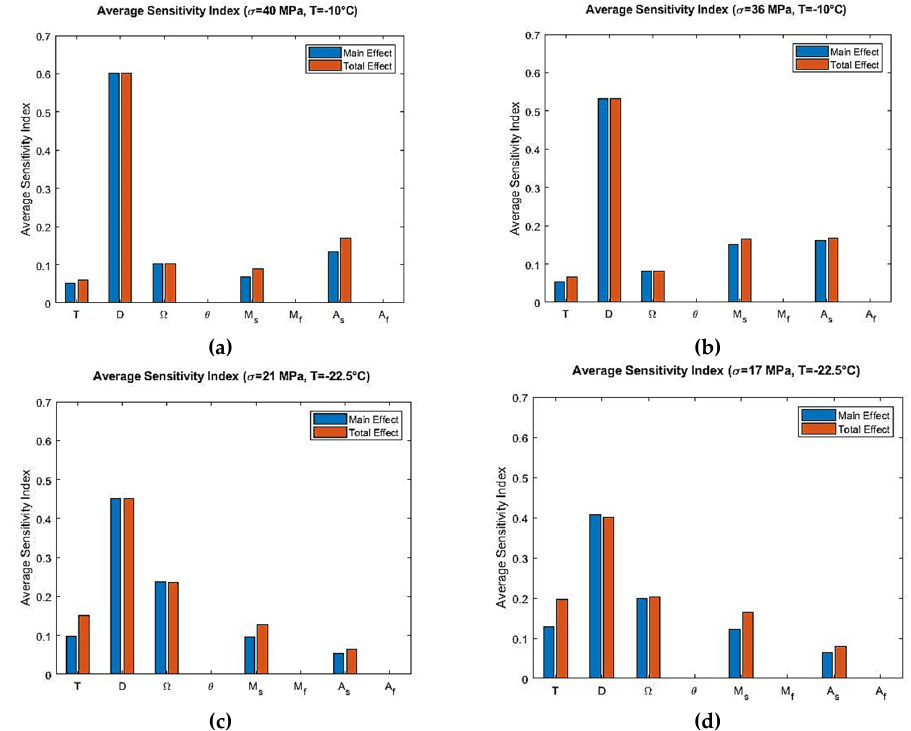
Figure 6. Sobol average sensitivity indices at simulated temperatures and maximum loading stress for the Tanaka model: ( a ) T = − 10 ◦ C, σ max = 40 MPa; ( b ) T = − 10 ◦ C, σ max = 36 MPa; ( c ) T = − 22.5 ◦ C, σ max = 21 MPa; ( d ) T = − 22.5 ◦ C, σ max = 17 MPa.